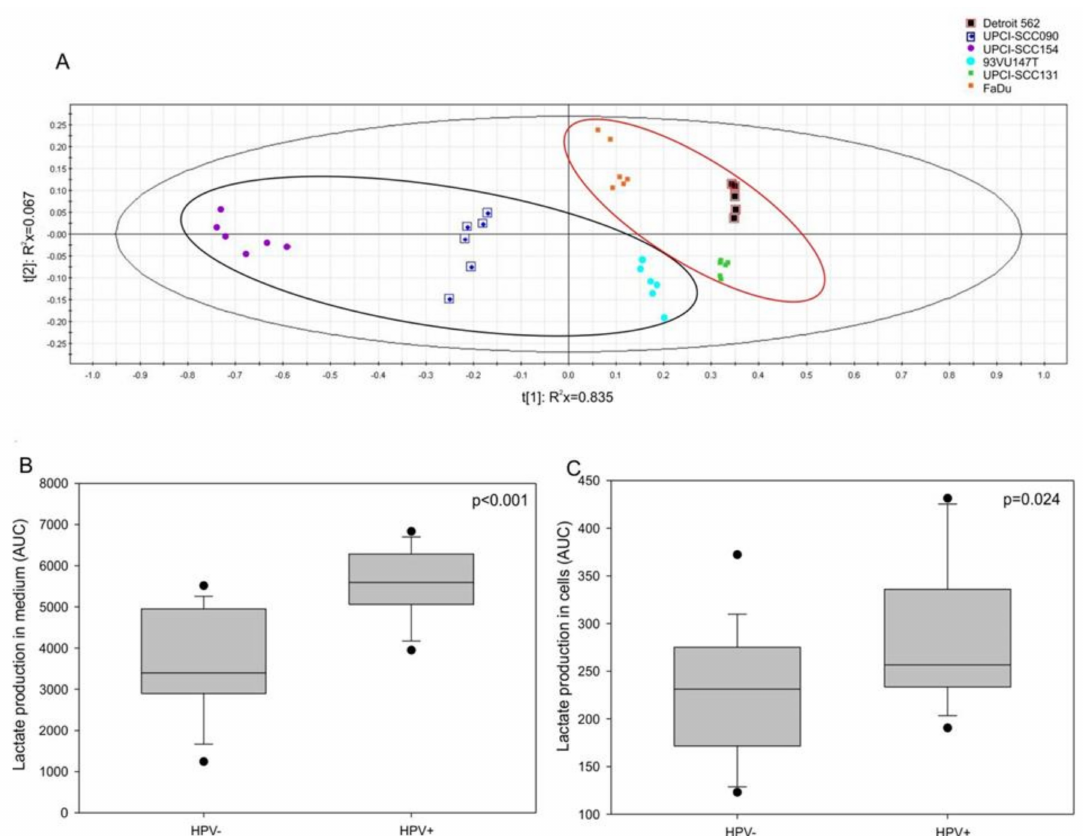
Figure 4. Lactate production in human cell lines. ( A ) Partial least-squares discriminant analysis (PLS-DA) for human papilloma virus (HPV)-positive and HPV-negative cell lines. Increase in lactate production in ( B ) the extracellular compartment ( p <0.001, Mann-Whitney test) and in ( C ) the intracellular compartment ( p = 0.024, Mann-Whitney test) of HPV-positive and HPV-negative